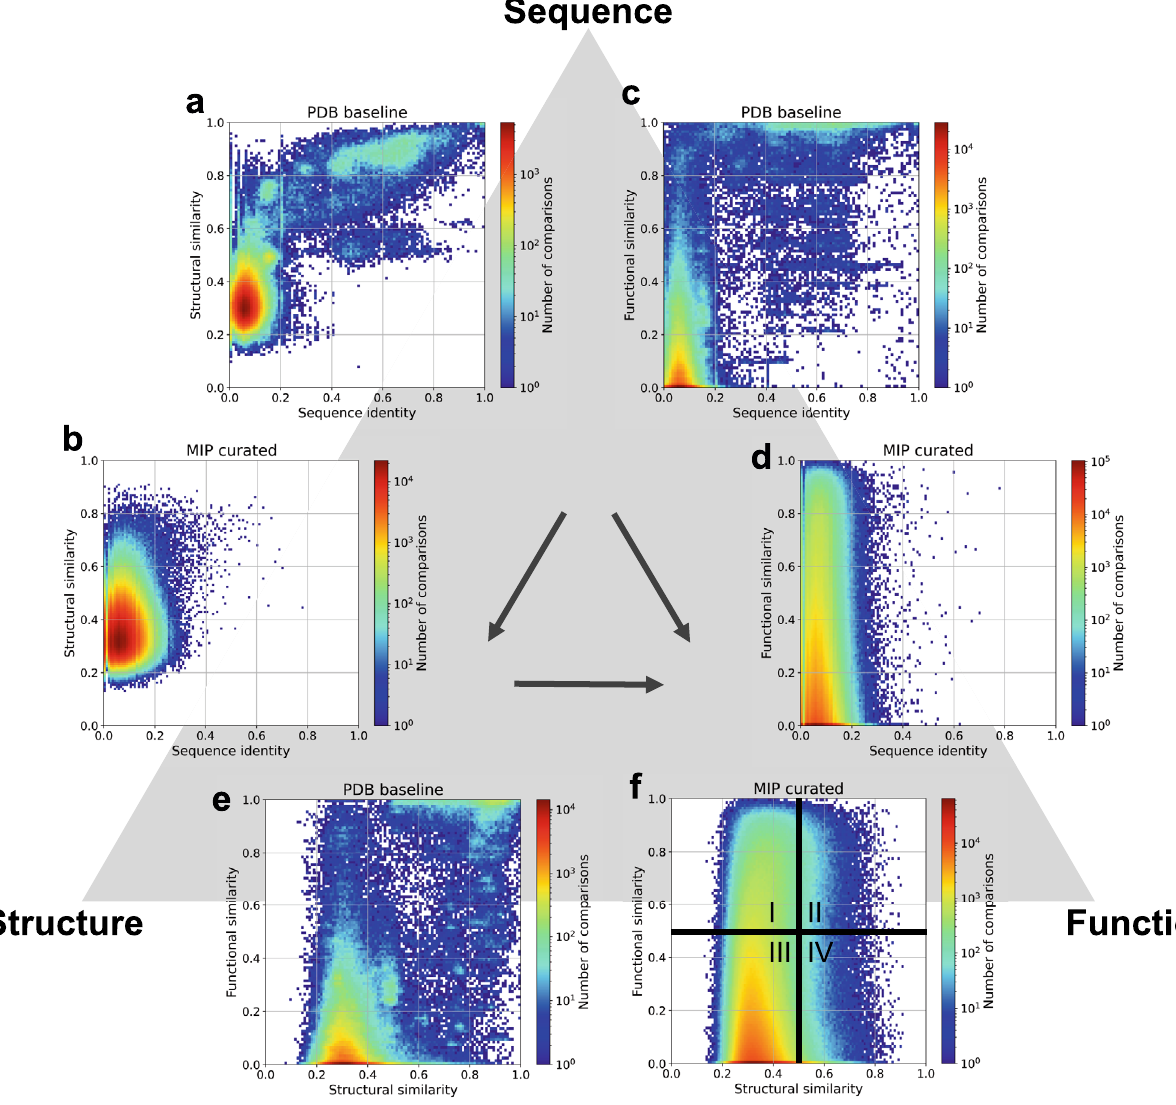
Fig. 2 | Sequence-structure-function relationships in both PDB and the MIP dataset. Pairwise comparisons of protein sequences (using sequence identity), structures (TM-score), and functions (cosine similarity between DeepFRI output vectors) for two datasets: a baseline from the PDB and the MIP_random5000_cu- rated dataset, containing 3,052 Rosetta generated models (see Tables S2 and S3). The PDB baseline dataset contains 1000 chains covering pairwise sequence simi- larities between 0 and 100% while the MIP dataset is a non-redundant set with mostly dissimilar sequences (sequence identity <30% threshold was imposed before sequentialdomainsplitting).Analysesofthesetwodatasetsinthisway lead ustothefollowingconclusions:sequenceidentityandstructuralsimilarityfollowa